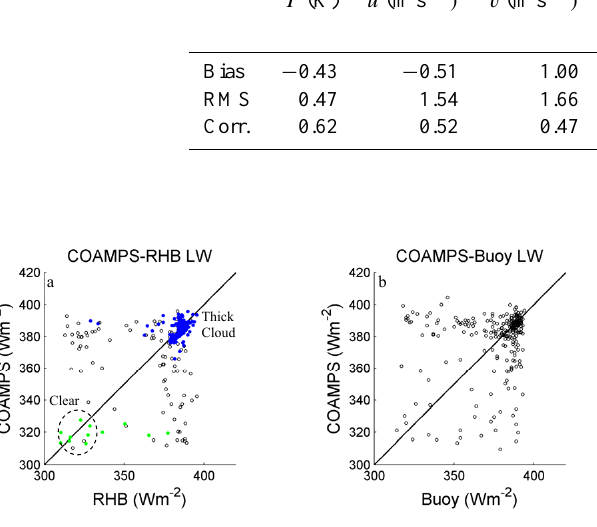
Fig. 12. Scatter p LWlots of surface downward LW between observations and COAMPS forecasts. Fig. 12. Scatter plots of surface downward LW between observa- (a) COAMPS vs. RHB; and (b) COAMPS vs. Buoy. The “clear” condition (green points) is de- fined here as P less than 1 g m -2 from both the COAMPS and the RHB; The “thick cloud” tions and COAMPS forecasts. (a) COAMPS vs. RHB; and (b) (blue points) is defined as LWP greater than 30 g m -2 from both the COAMPS and the RHB. COAMPS vs. Buoy. The “clear” condition (green points) is de- fined here as LWP less than 1gm − 2 from both the COAMPS and the RHB; The “thick cloud” (blue points) is defined as LWP greater than 30gm − 2 from both the COAMPS and the